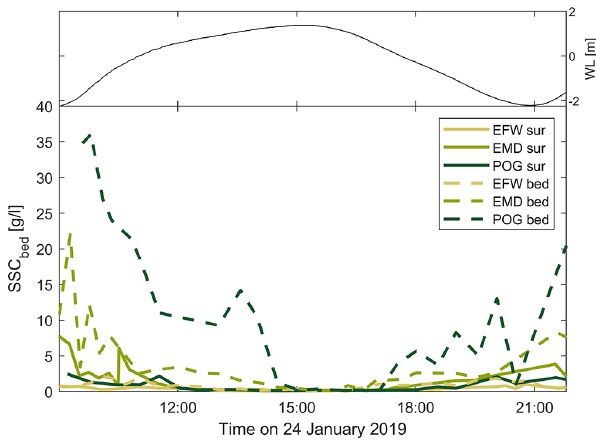
Figure 13. SSC based on water samples collected in the Fairway to Emden (station SB_EFW and SB_EMD) and the lower Ems River (SB_POG) on 24 January 2019 near the bed (top) and near the sur- face